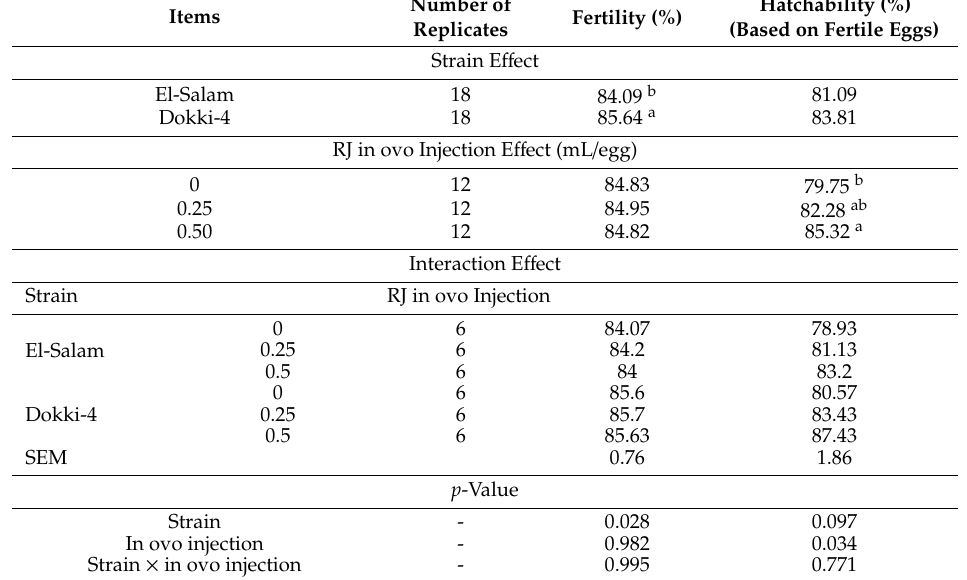
Table 1. Fertility and hatchability percentages of two chicken strains (El-Salam and Dokki-4) injected in ovo with two di ff erent levels of royal jelly (RJ; 0.25, 0.5 mL / egg) compared to counterpart control strains (0 mL RJ / egg) and the interaction between strain and treatment